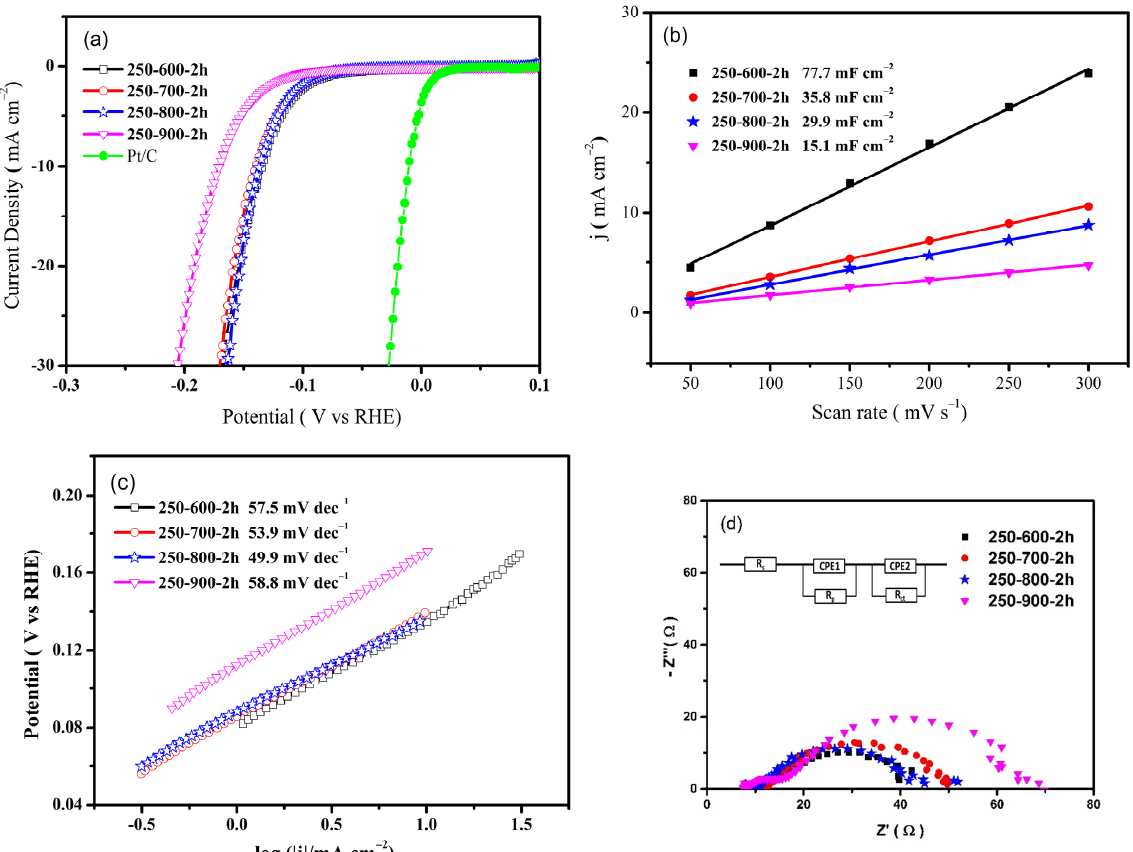
Figure 4. ( a ) polarization curves, ( b ) capacitance plots (at 0.15 V), ( c ) Tafel plots, and ( d ) Nyquist plots ( η = 250 mV) of different catalysts in 0.5 M H 2 SO 4 solution.